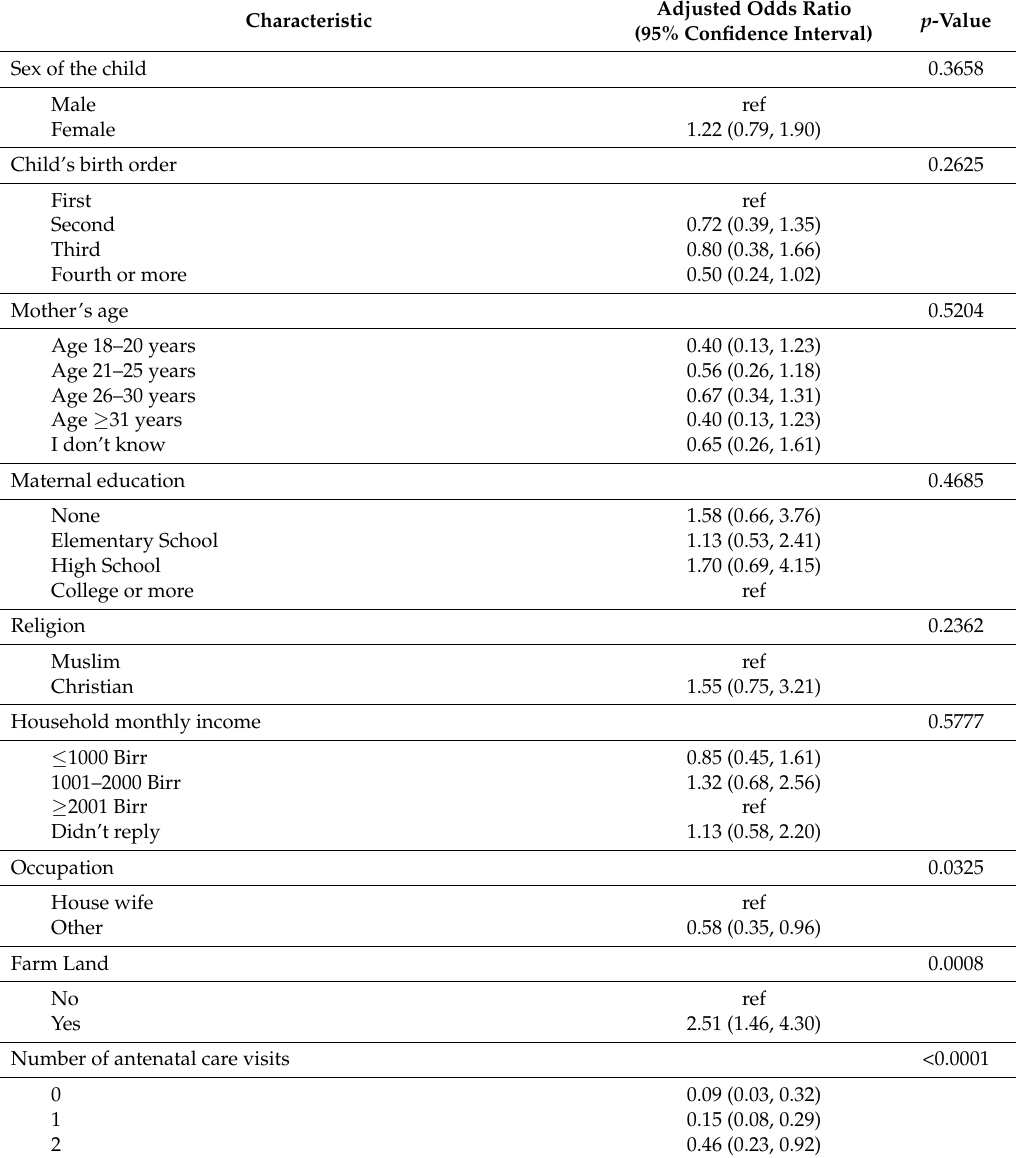
Table 3. Mother and child socioeconomic characteristics, maternal vaccine knowledge, and their relationship to full childhood immunization according to a multivariable logistic regression model, Worabe, Southern Nations, Nationalities, and Peoples’ Region, Ethiopia,